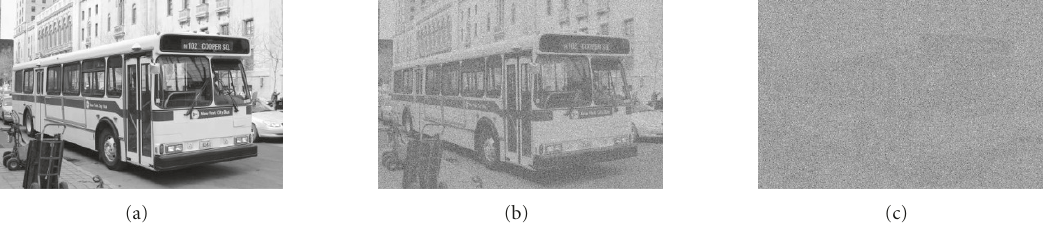
Figure 4: (a) Original bus (© come.to/torontobus); (b) bus with AWGN σ 2 = 50; (c) bus with AWGN σ 2 = 500.